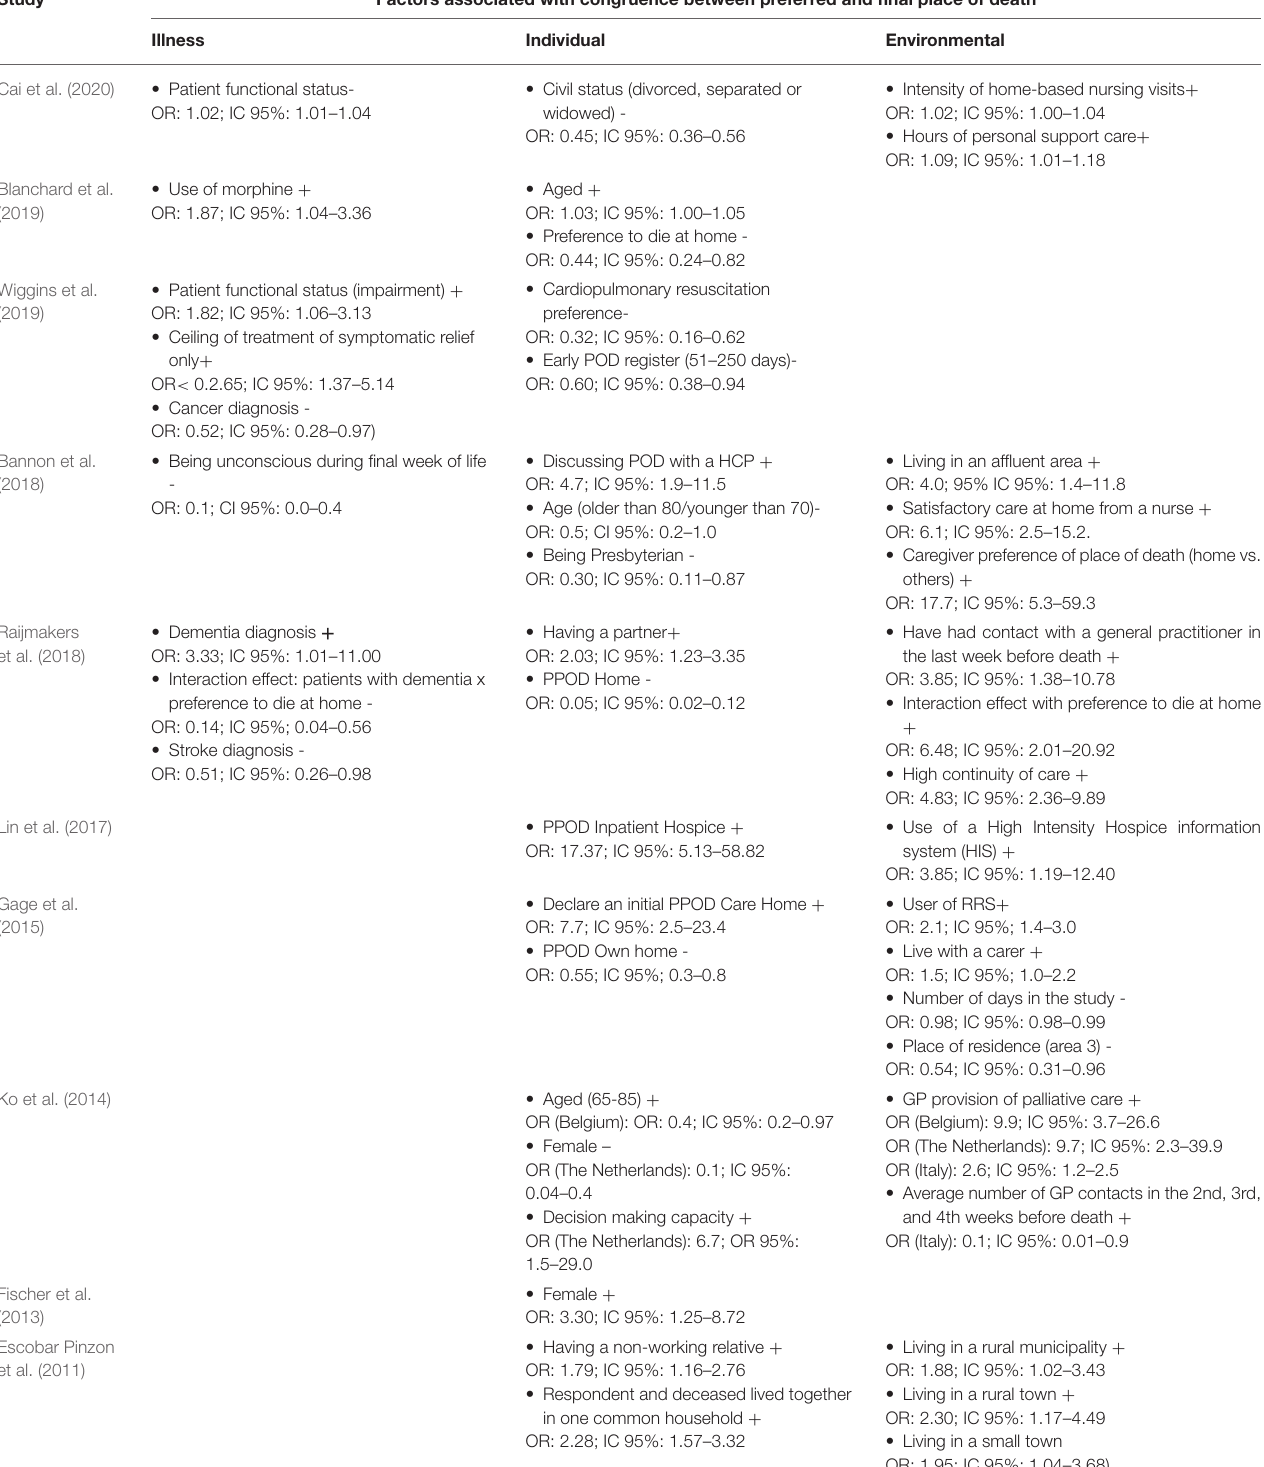
TABLE 3 | Factors associated with congruence between preferred and final place of